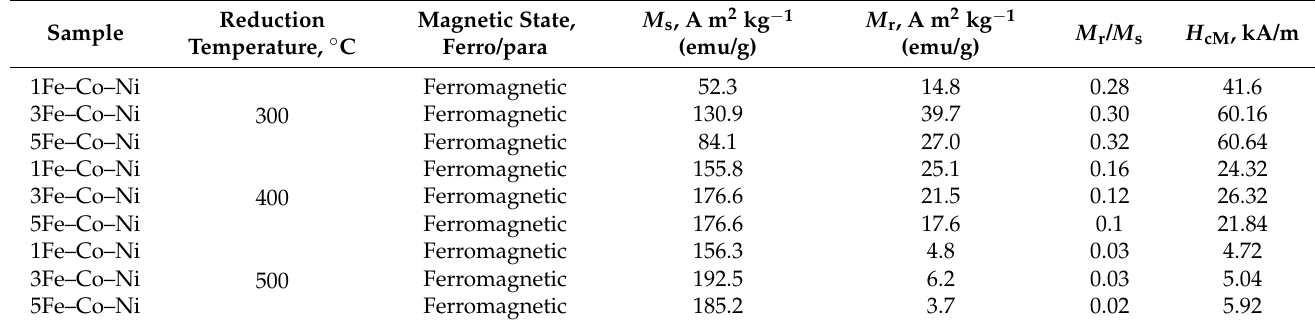
Table 3. Magnetic parameters of investigated Fe–Co–Ni